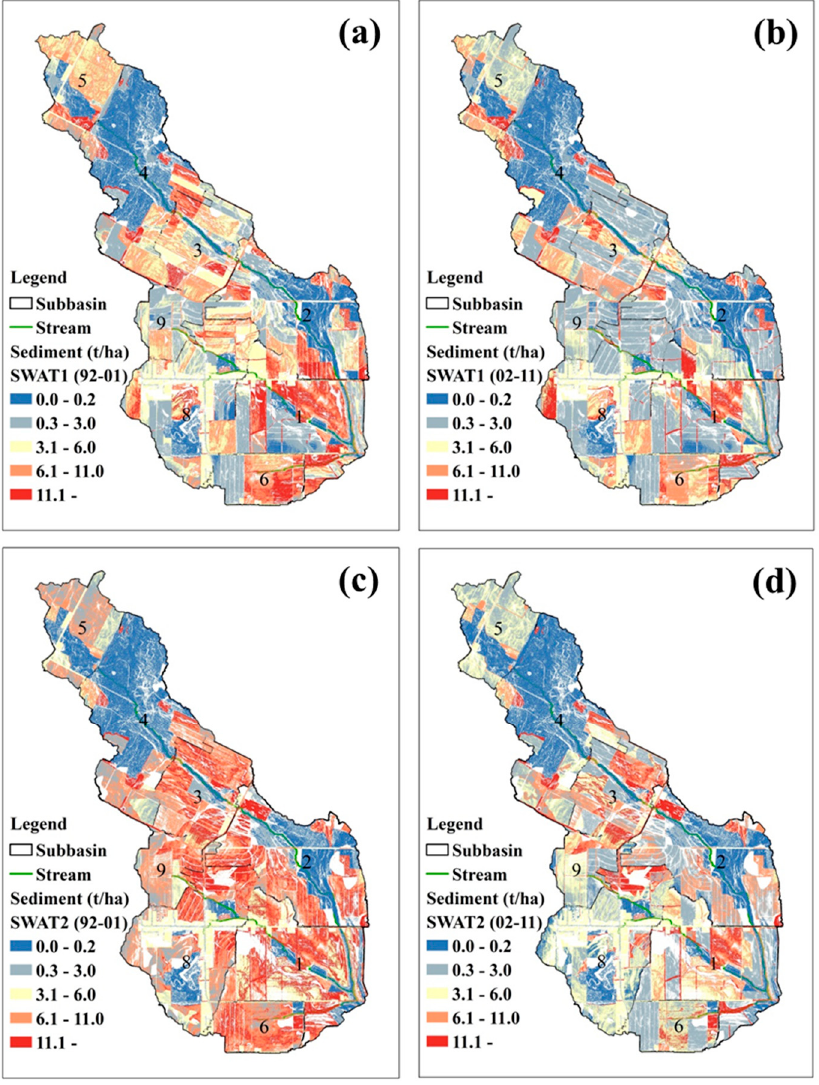
Figure 13. Comparisons of mean annual sediment loadings from HRUs in the BBW between the periods 1992–2001 ( left panels ) and 2002–2011 ( right panels ) simulated with SWAT1 [( a ) versus ( b )] periods 1992 – 2001 ( left panels ) and 2002 – 2011 ( right panels ) simulated with SWAT1 [( a ) versus and SWAT2 [( c ) versus ( d ( b )] and SWAT2 [( c ) versus ( d )].